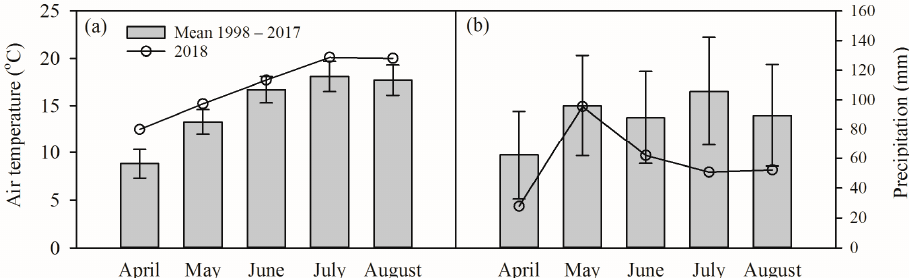
Figure 2. Monthly air temperature ( a ) and precipitation ( b ) in 2018 (in line) and the average from 1998 to 2017 (in bar plot, mean ± standard deviation). Data from the Deutscher Wetterdienst.